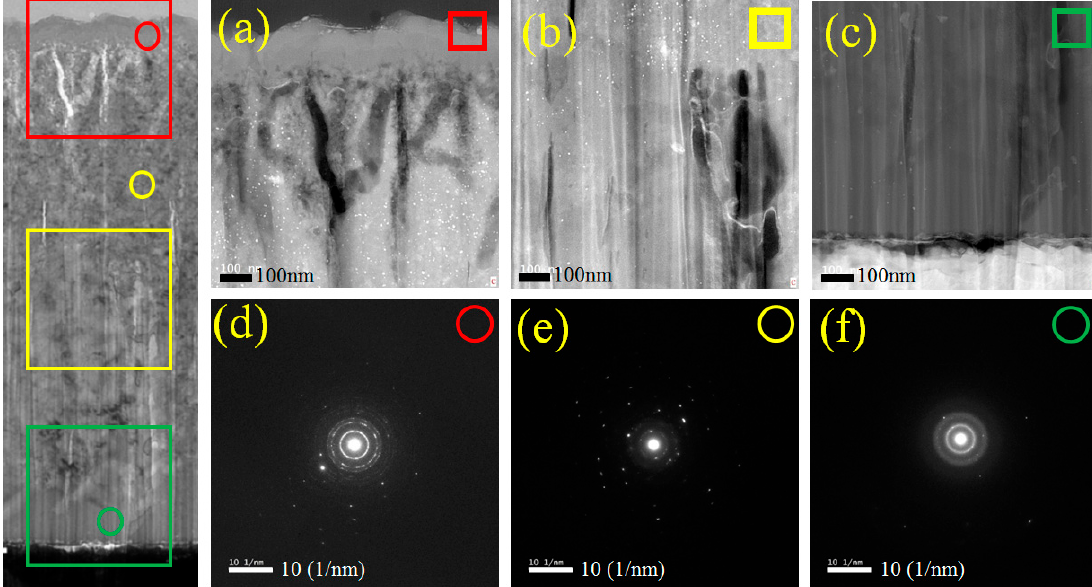
Figure 7. The high angle annular dark field (HAADF) and selected area diffraction (SAD) images of three different regions (from top to bottom) of the film cross-section after 1500 sec Ag-NPS induced etching.HAADF images show the ( a ) red, ( b ) yellow, and ( c ) green regions. The SAD images show the ( d ) red, ( e ) yellow, and ( f ) green circles.